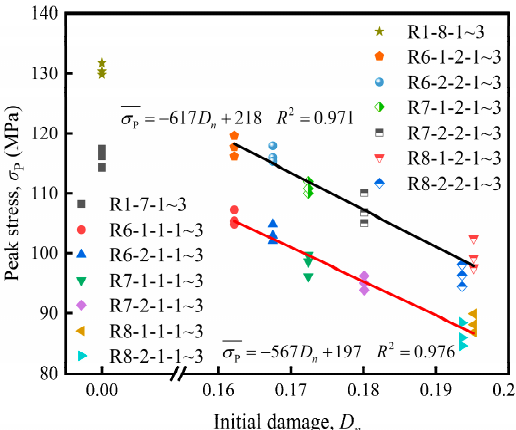
Figure 15. The peak stress of rock specimen under different initial damage in the SHPB test.